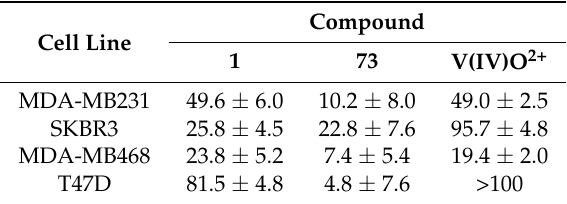
Table 15. Cytotoxicity data of 73 compared to quercetin and oxovanadium(IV) cation 1,2